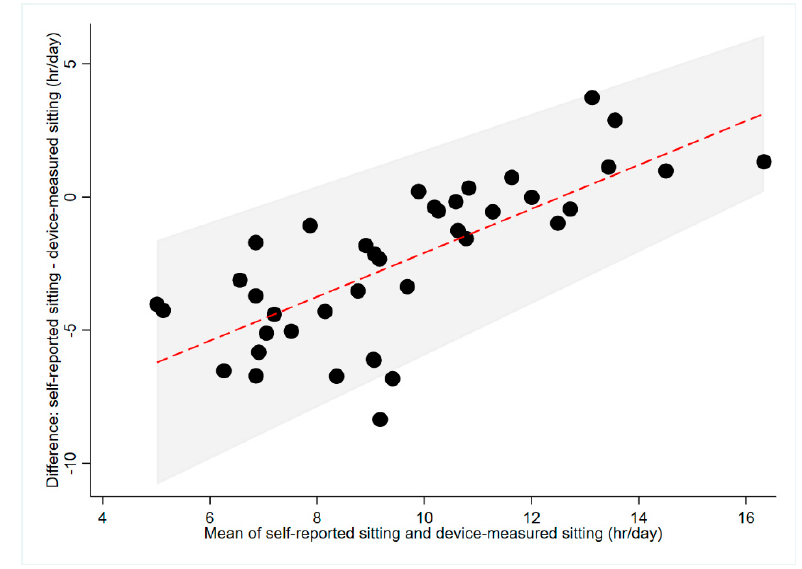
Figure 4. Agreement between self-reported and device-measured sitting time ( n = 41). The red line represents the mean difference, the grey shaded area represents the limits of agreement and the size of the black dots differs depending on the number of participants that correspond to that value.